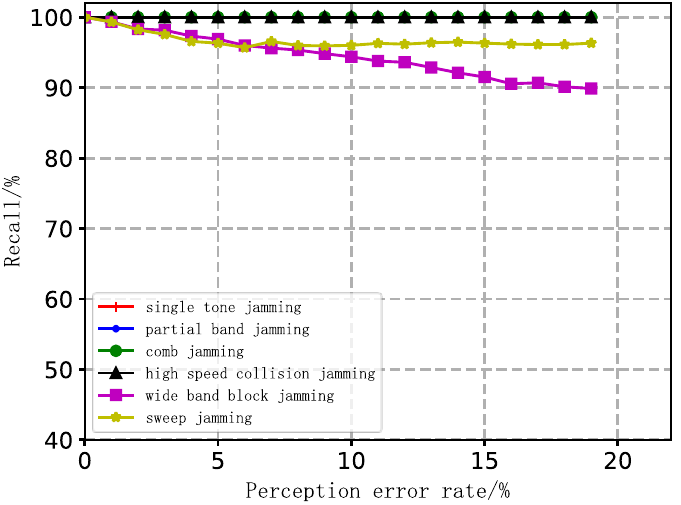
Figure 4. Frequency domain feature extraction recall.